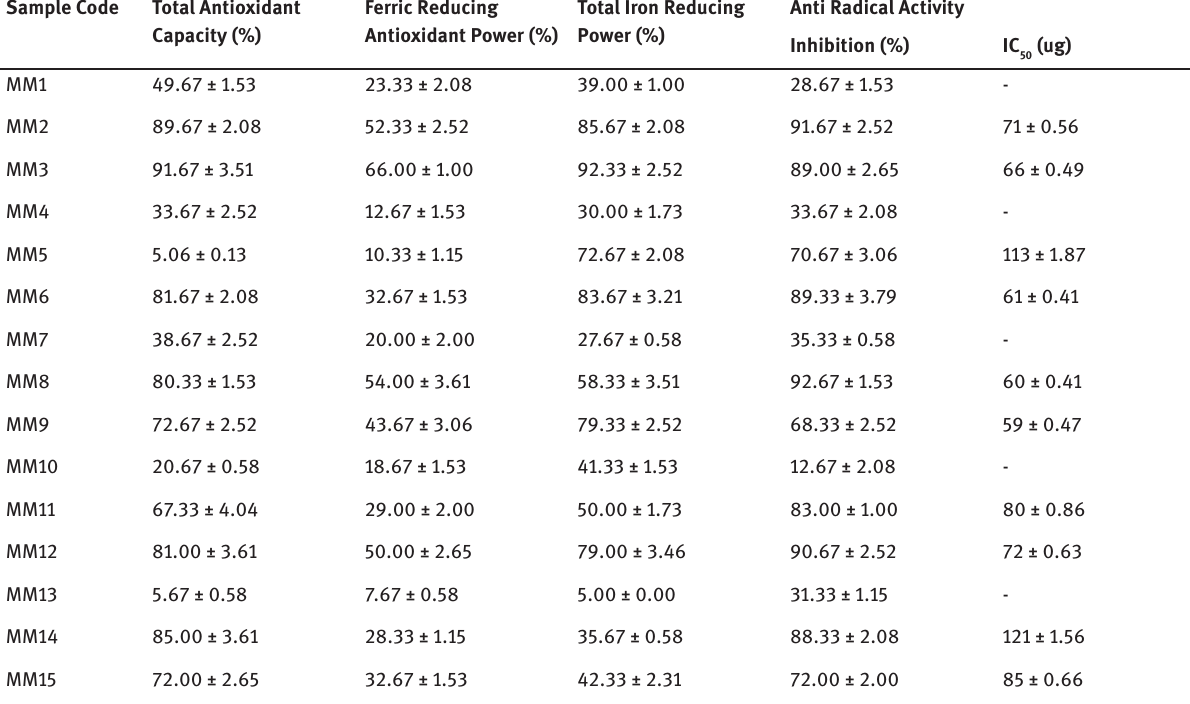
Table 2: Antioxidant Activity of Selected